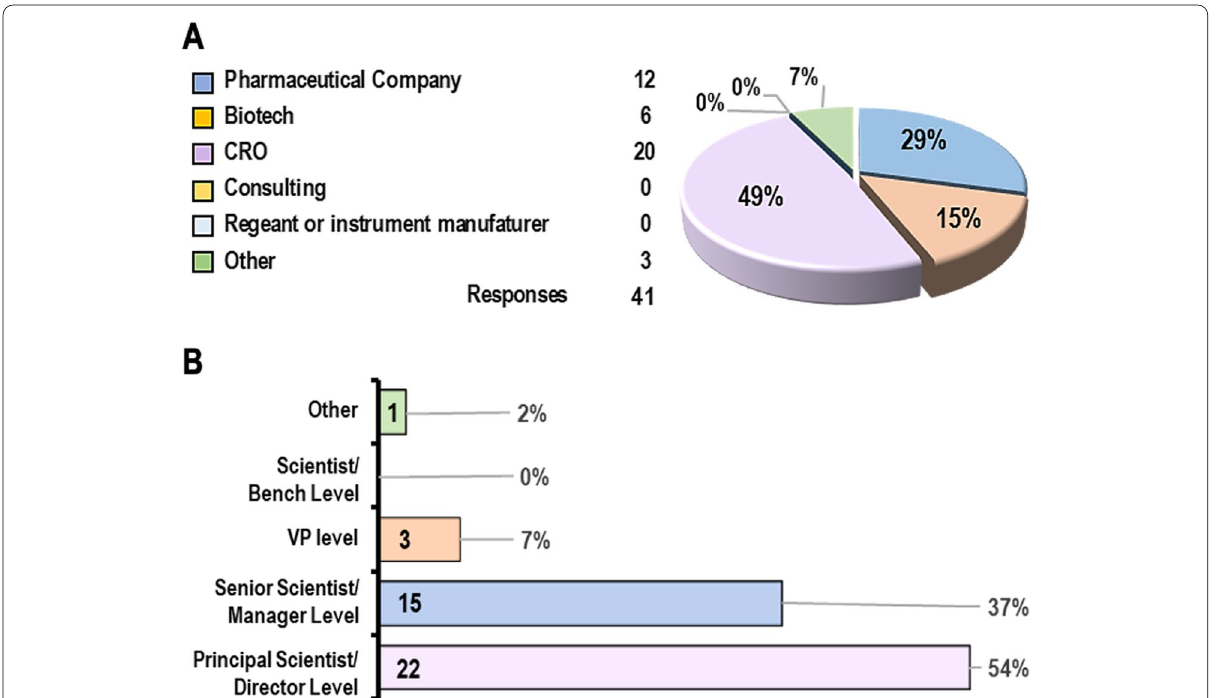
Fig. 1 Pre‑workshop survey—demographics of respondents. The distribution of workplace ( A ) and job title of the 41 survey respondents ( B